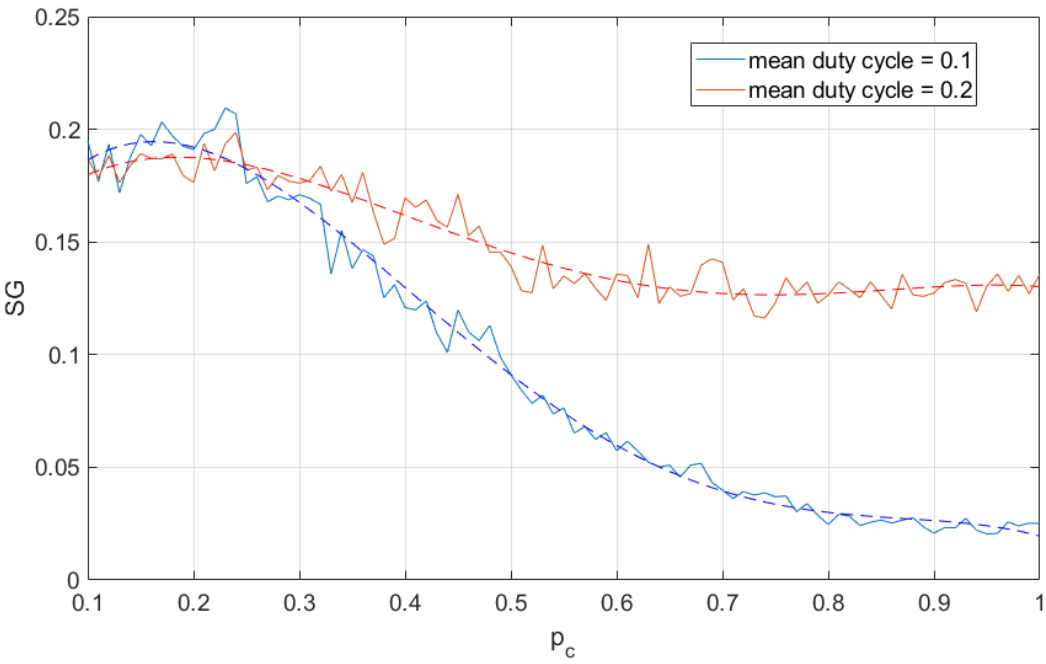
Figure 6. Second largest cluster size as function of node operation probability (different mean duty cycle). Dashed lines are a fourth-degree polynomial